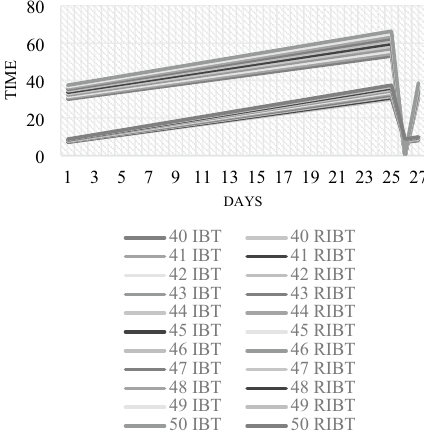
Fig. 9 In beat time and remaining in beat time for power reserves between 40 and 50